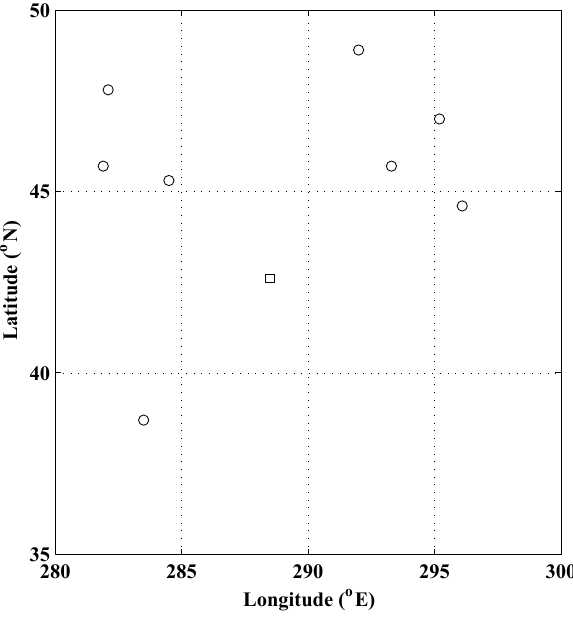
Figure 1. Geographical position of the GNSS ground receivers (cir- cle) and MHJ ground ionosonde